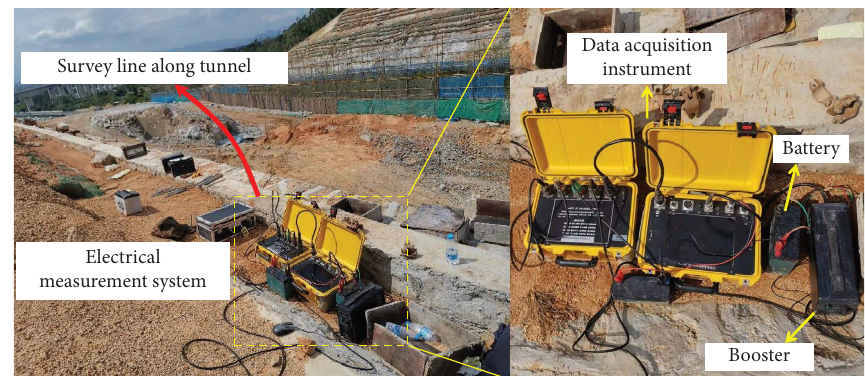
Figure 5: Electrical measurement system.